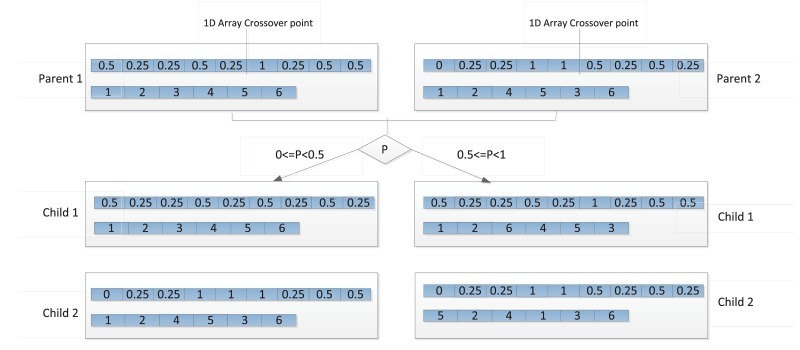
Crossover Operation of Genome S.